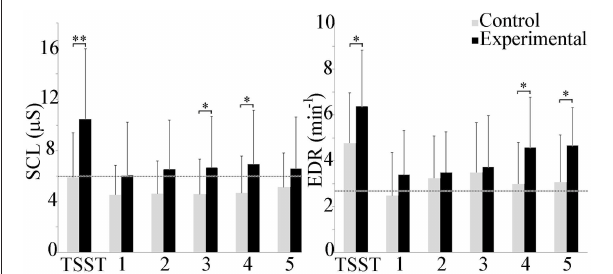
FIGURE 3 | Group differences in mean SCL and EDR rate. The experimental group exhibited higher electrodermal activity throughout the experiment. Average baseline scores shown by dotted line. * p ≤ 0 . 05 ; ** p ≤ 0 . 001